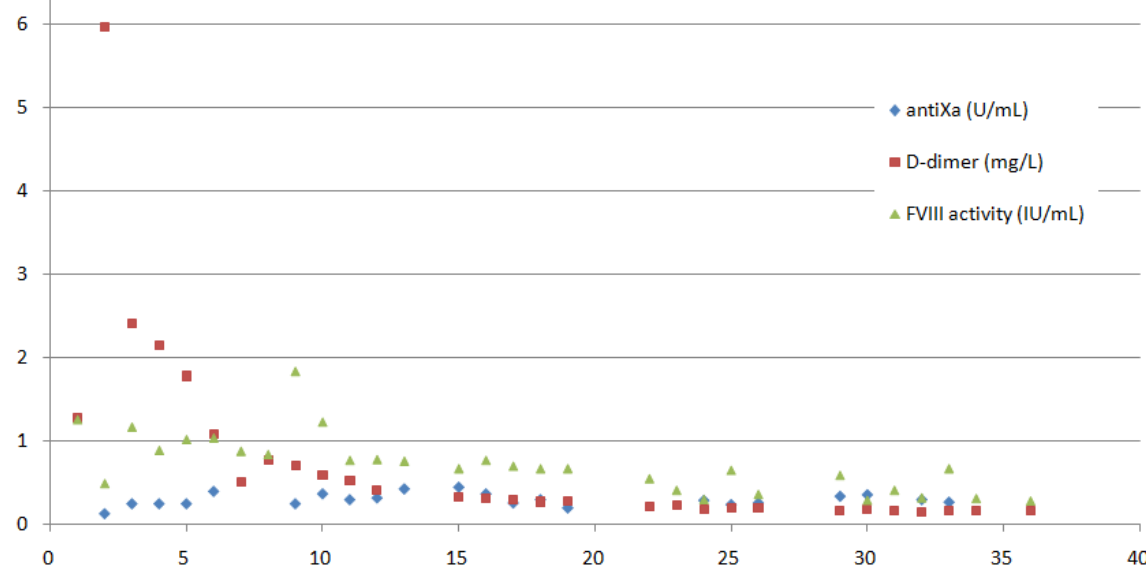
Figure 1. FVIII activity (IU/mL), D-dimer (mg/L) and antiXa (U/mL) measurements on the y -axis are presented throughout the 36-day long hospitalisation (the x -axis demonstrates the time in days). The patient was mechanically ventilated until day 18 of the hospitalisation; FVIII and dalteparin were dosed twice daily until day 22, and from then on once